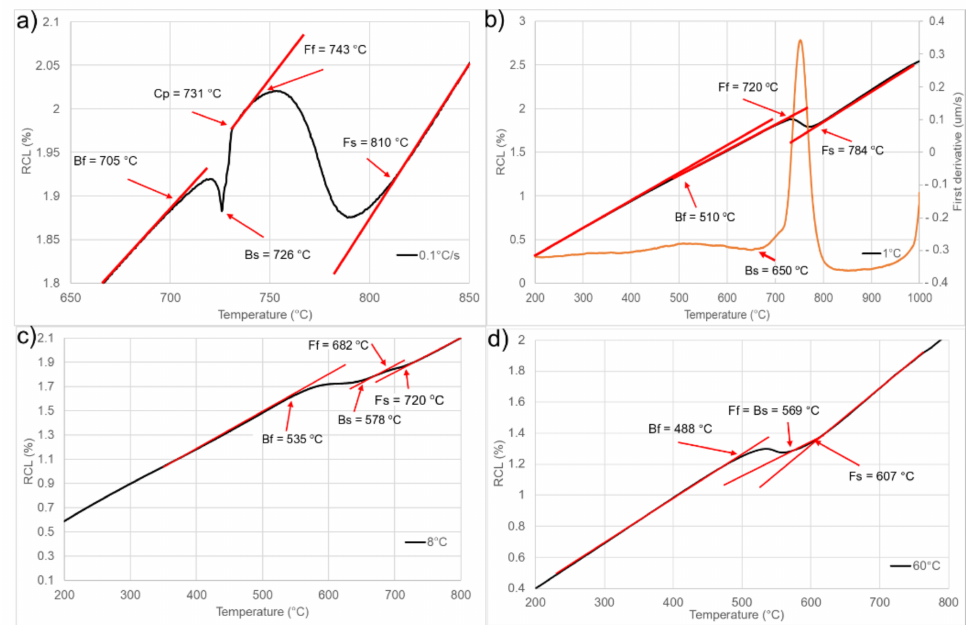
Figure 4. Selected dilatometric curves during cooling at different rates: ( a ) 0.1 ◦ C/s, ( b ) 1 ◦ C/s, ( c ) 8 ◦ C/s, ( d ) 60 ◦